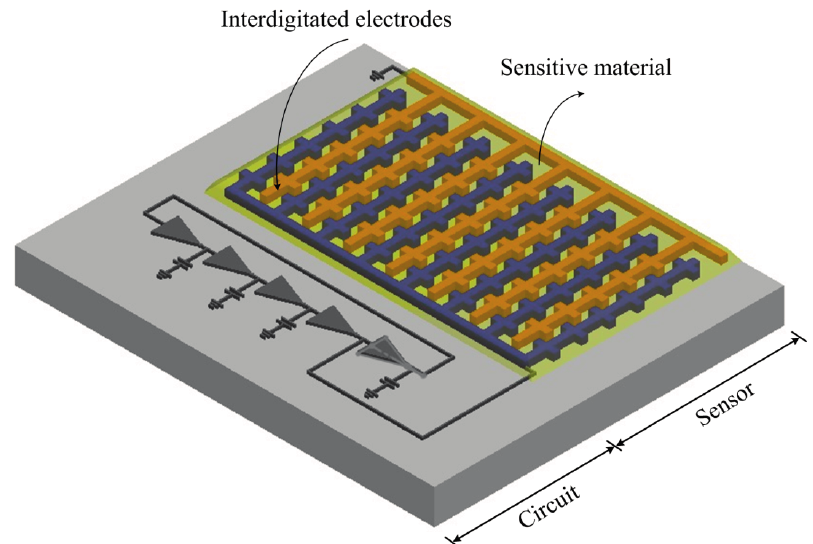
Figure 1. Schematic structure of the integrated humidity